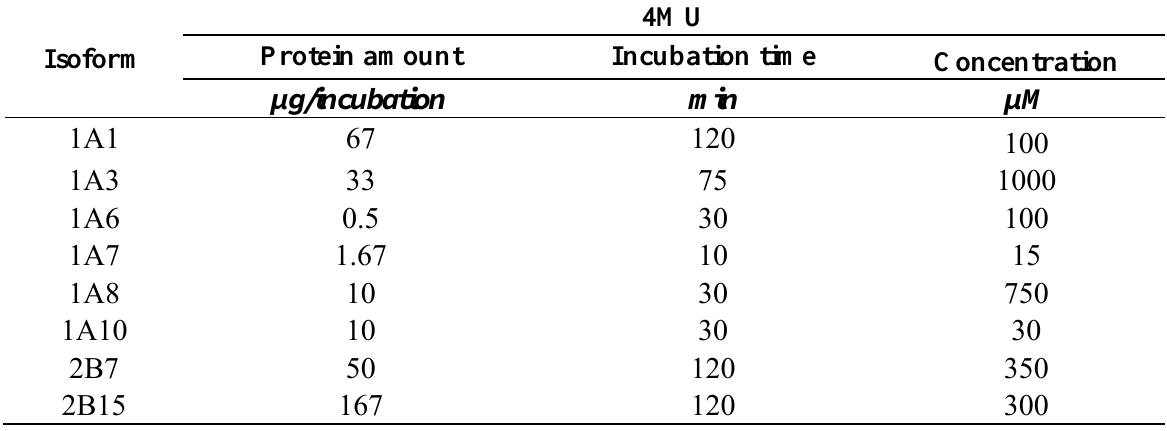
Table 1. Cell lysate protein amount, incubation time, and substrate concentration used for the inhibition of 4-methylumbelliferone (4MU) glucuronidation by Andrographis paniculata and Orthosiphon stamineus